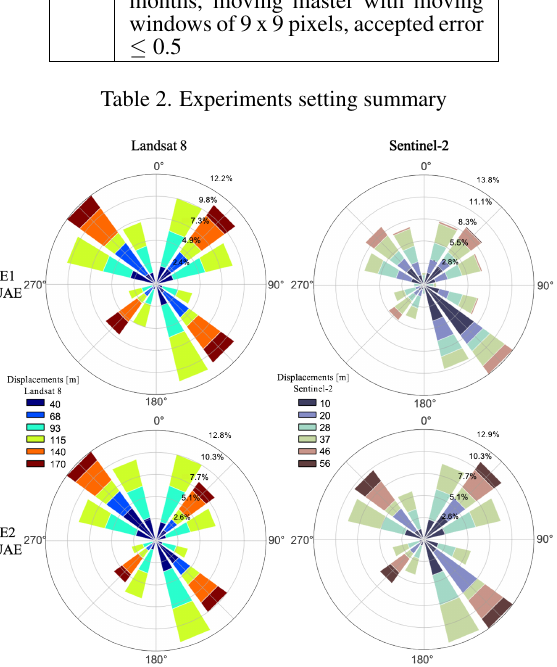
Figure 4. Results synthesis for the experiment E1 and E2 (Table 2) on the UAE study